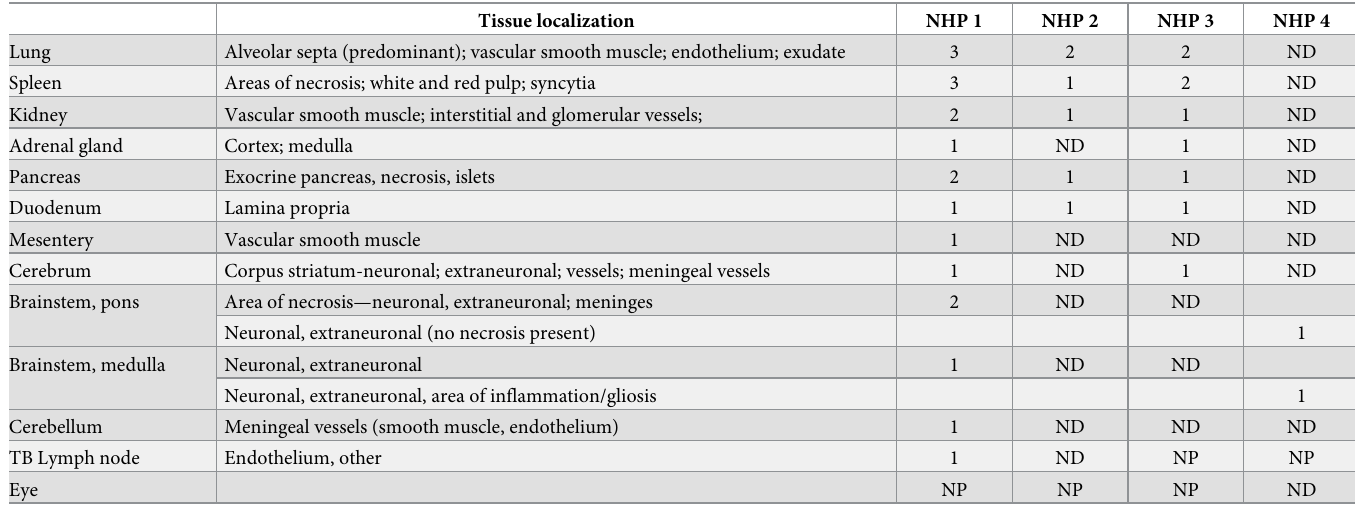
Table 3. In situ hybridization